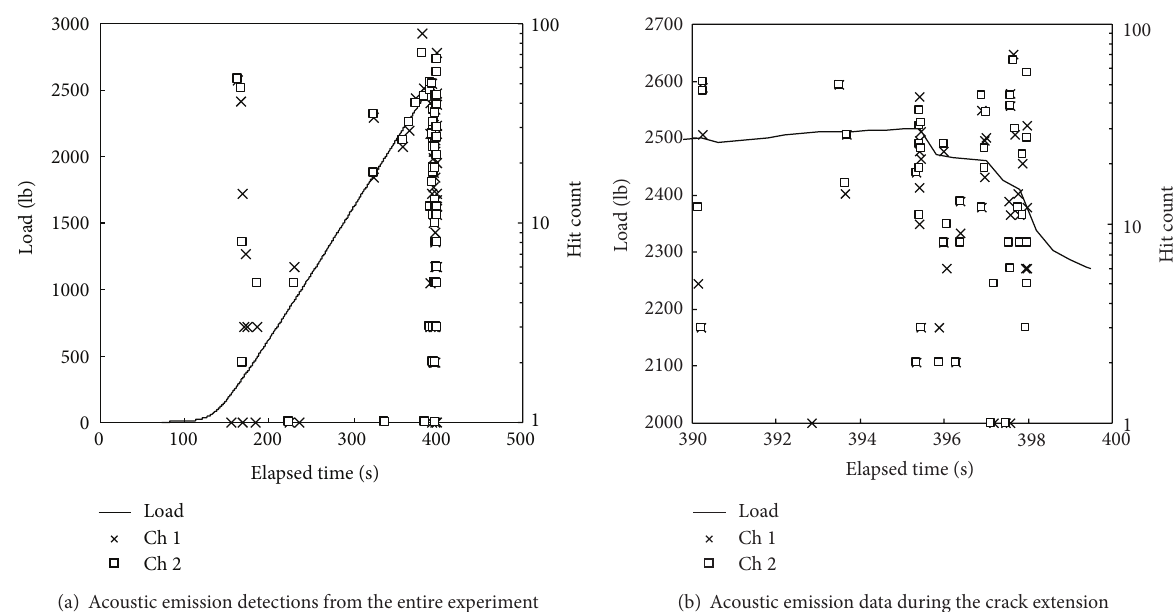
Figure 9: Example of test results for panel load to onset of crack extension. Each point on the plot is a single strain wave detected by either sensor 1 or 2. Although some measurements appear simultaneous in recording, there are microseconds between recordings.